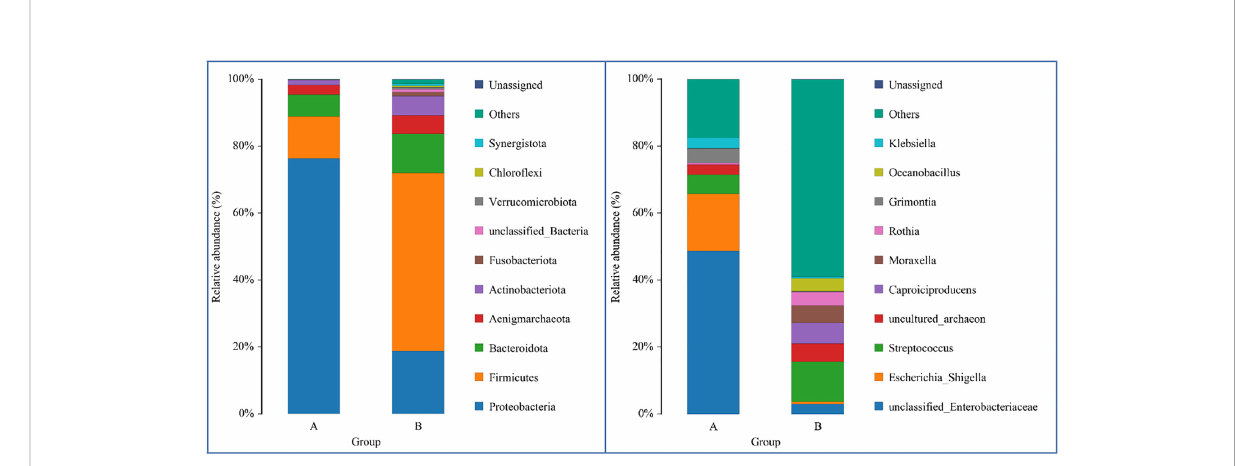
FIGURE 3 Comparison of LRTI children with/without hematological malignancies at the phylum/genus level. The bar chart on the left was the comparison at the phylum level, while the bars on the right were at the genus level. Bar A re fl ects BALF samples of LRTI children with hematological malignancies; Bar B re fl ects BALF samples of LRTI children without hematological